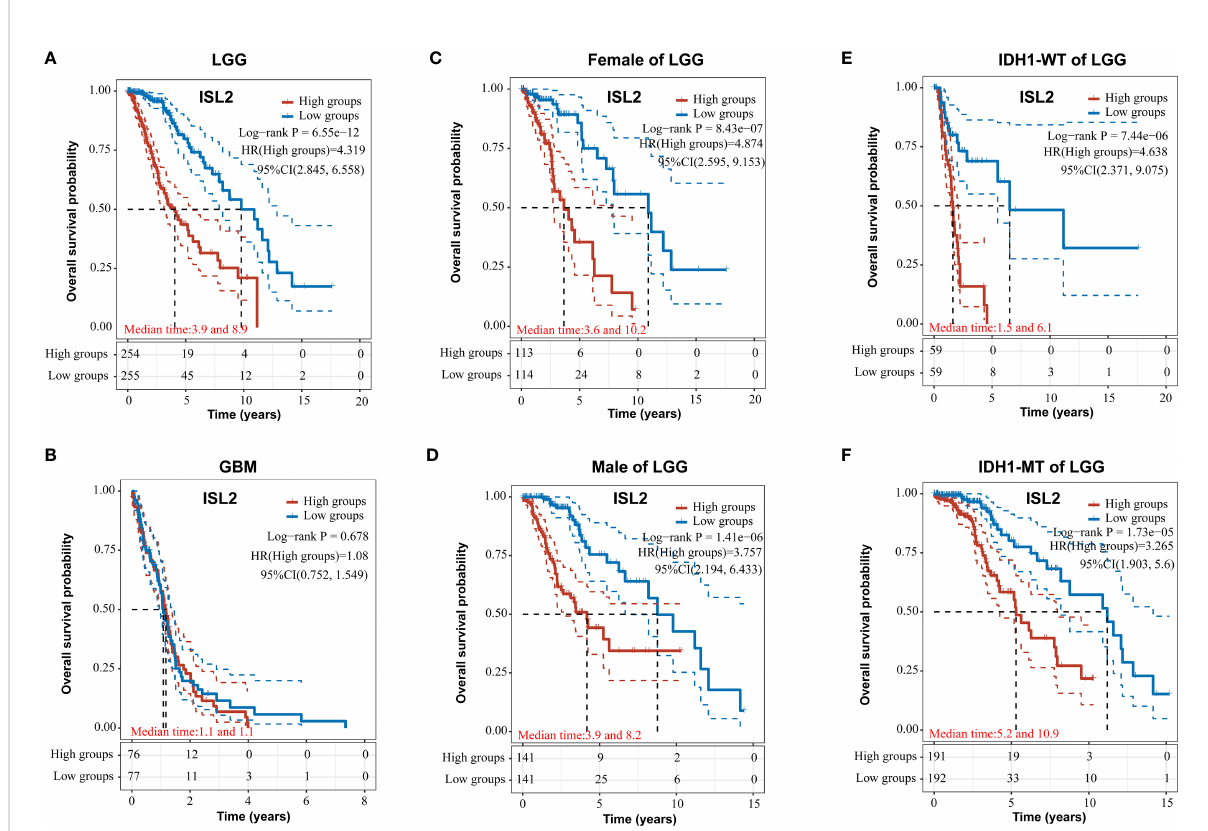
FIGURE 3 ISL2 correlates with poor overall survival in LGG patients. (A, B) The prognostic signi fi cance of ISL2 in LGG (A) and GBM (B) glioma tissues was analyzed in the TCGA database. (n (LGG)=509; n (GBM)=153). (C, D) The overall survival of female and male LGG patients with different ISL2 expression levels (n (female)=227; n (male)=282). (E, F) Kaplan – Meier survival curve showing the effects of isocitrate hydrogenase 1 (IDH1) status on overall survival in LGG patients with high versus low ISL2 expression levels. WT, wild-type; MT, mutated. HR (High exp) represents the risk coef fi cient of the samples in the high expression group relative to the samples in the low expression group: if HR > 1 means the gene is a risk factor, if HR < 1 means the gene is a protective factor. 95% CL represents the HR con fi dence interval; median time represents the time (in years) corresponding to a survival rate of 50% in both the high and low expression